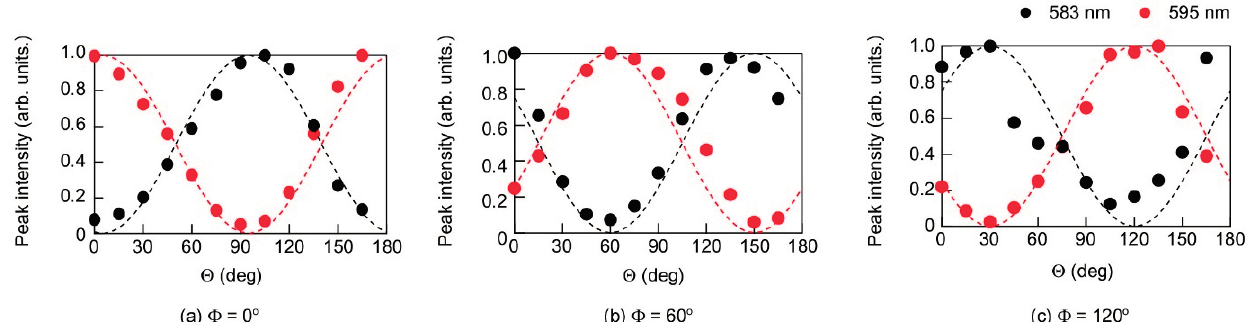
Figure 5. Polarization characteristics of the defect mode peaks at 583 and 595 nm in the 1D PC with the NLC defect for three applied electric field directions: ( a ) Φ = 0°, ( b ) Φ = 60°, and ( c ) Φ =